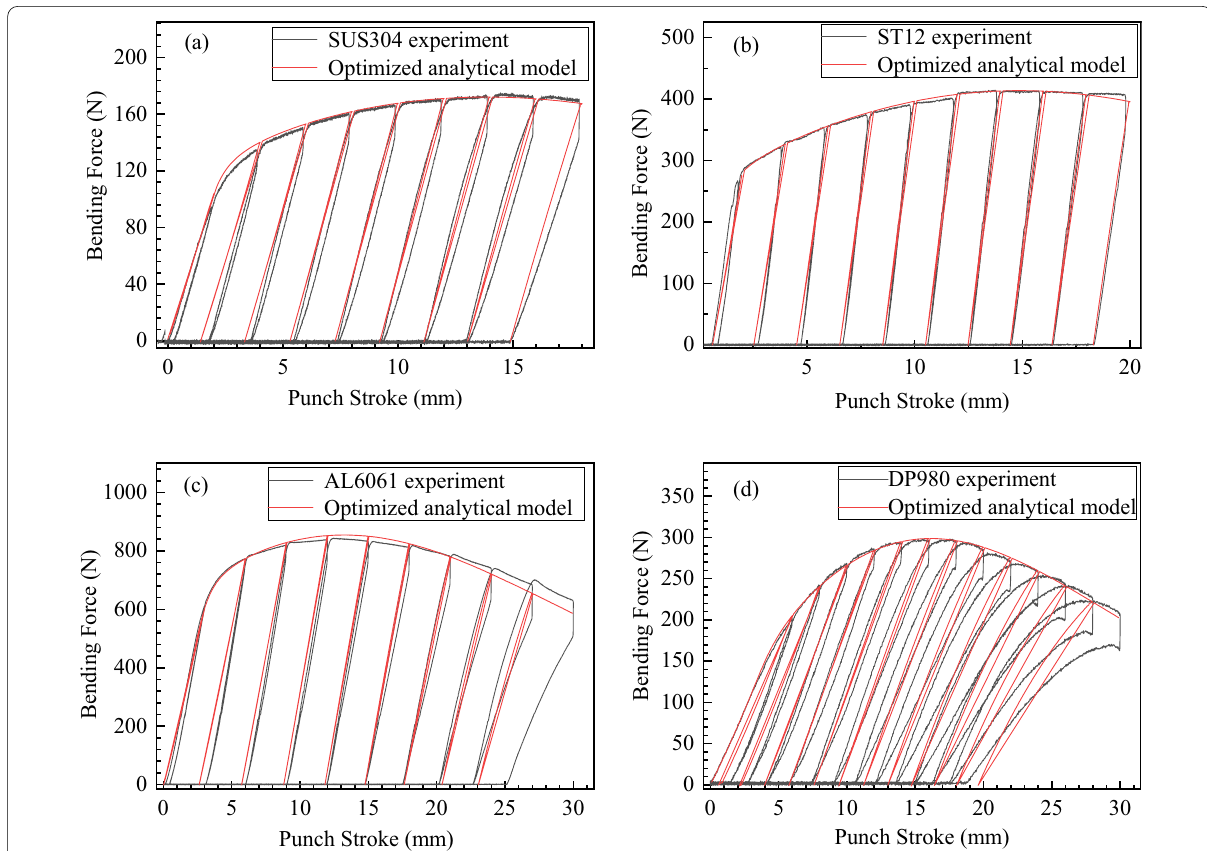
Figure 20 Comparison of the calibrated loading force stroke curve with experimental results: a SUS304, b ST12, c AL6061, d